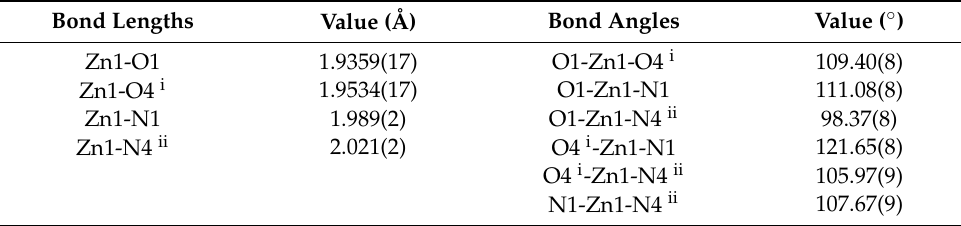
Table 3. Selected bond length and angles of complex 1 (Å, ◦